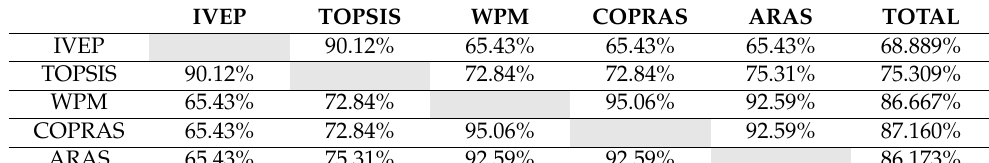
Table 8. Computing similarities and total similarities of ranks using the Hamming distance.